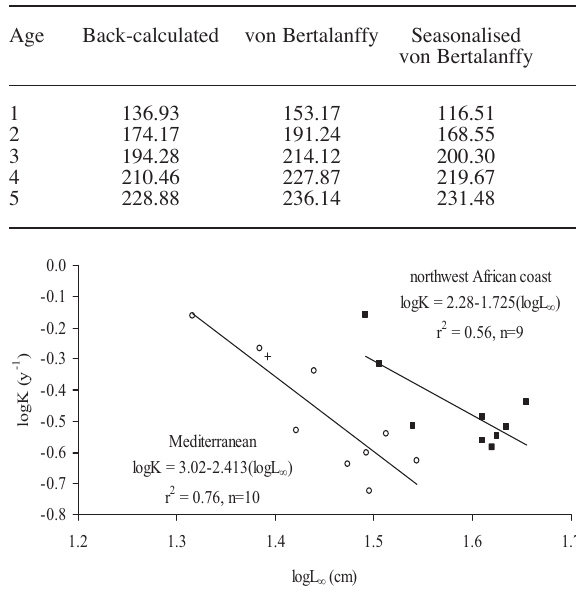
F IG . 5. – Auximetric plot for round sardinella for different areas of the Mediterranean (open circles), including the northern Aegean (cross), and the northwest African coast (solid